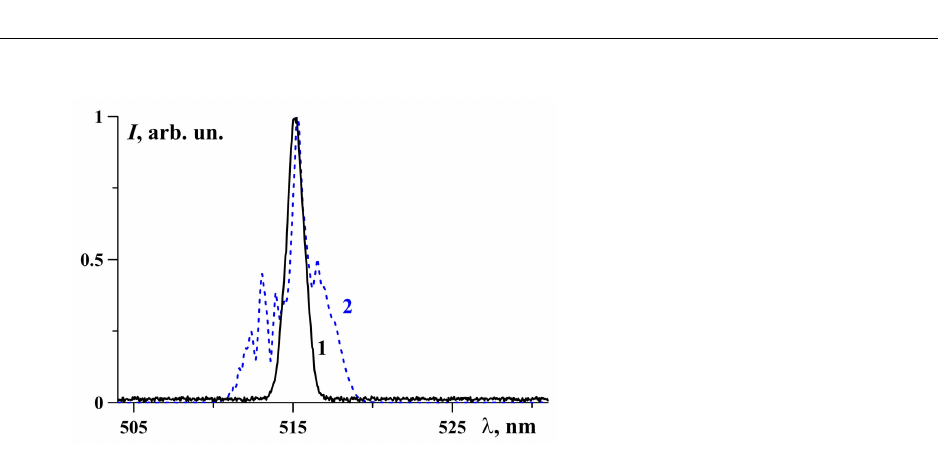
Figure 3. The spectra of laser pulse at E p = 3 µ J at entrance (line 1) and exit (line 2) of CSVO crystal. To evaluate β , the transmittance T of the samples was measured as a function of the incident pulse energy E p . The experimental results for the case when the c-axis of the crystals was parallel to the laser beam polarization are presented by the points in Figure 4a. The uncertainties in measurements (Figure 4) are determined by fluctuations of input ( ± 3%) and transmitted ( ± 10%) pulses energy.